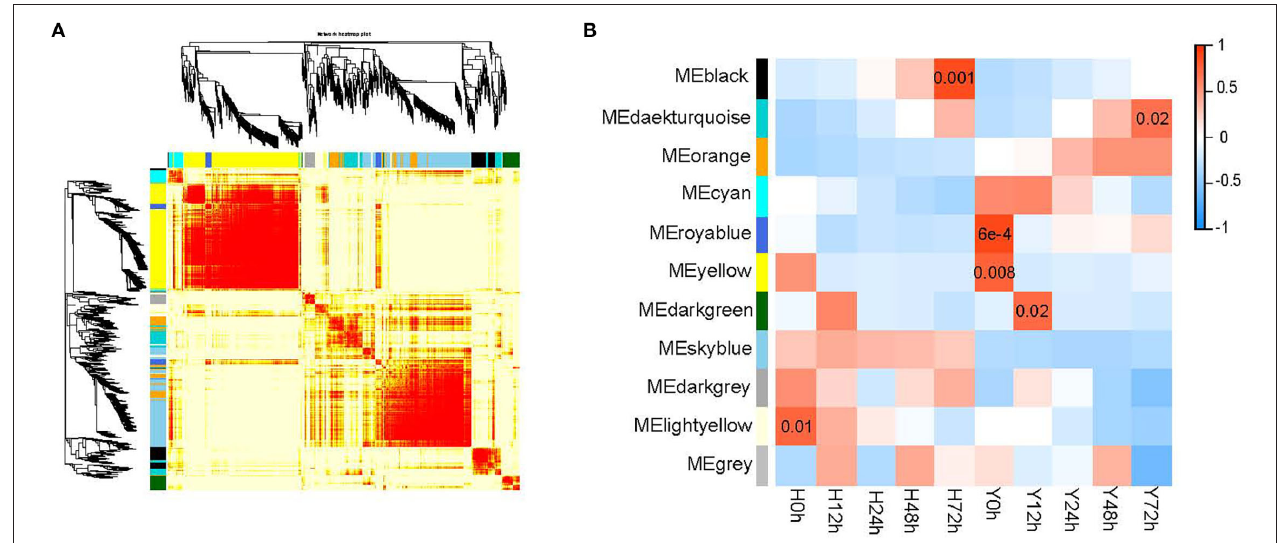
FIGURE 6 | The construction of gene co-expression modules in both cultivars for five time points. (A) Hierarchical clustering tree (dendrogram) of genes based on co-expression network analysis in Y and H. The branches correspond to modules of highly interconnected genes. Each module was assigned by a unique color; with ungrouped genes colored gray. (B) Correlation between gene co-expression modules (row) and resistance to B. cinerea for two cultivars at five time points (column). The correlation coefficients and the p -value are presented at the top and bottom of the corresponding boxes. The color legend for modules is indicated on the